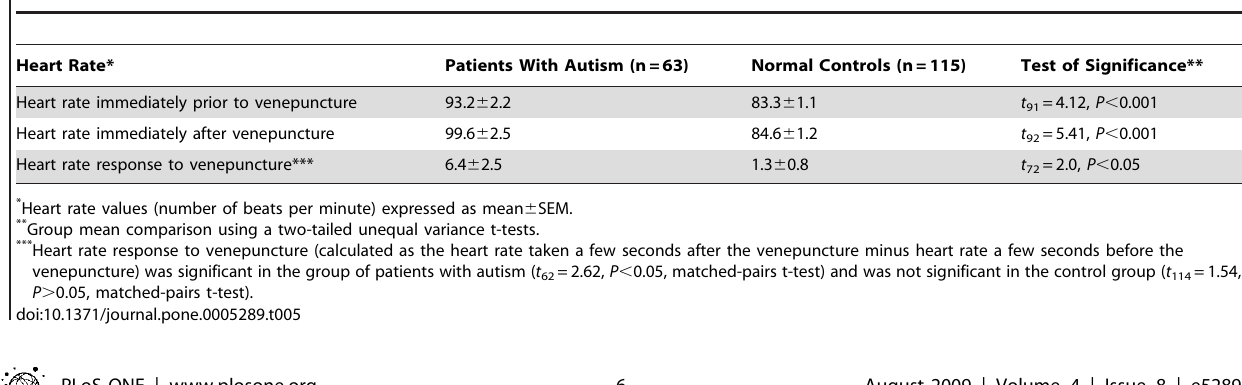
Table 5. Heart Rates measured during Blood Drawing Procedure.